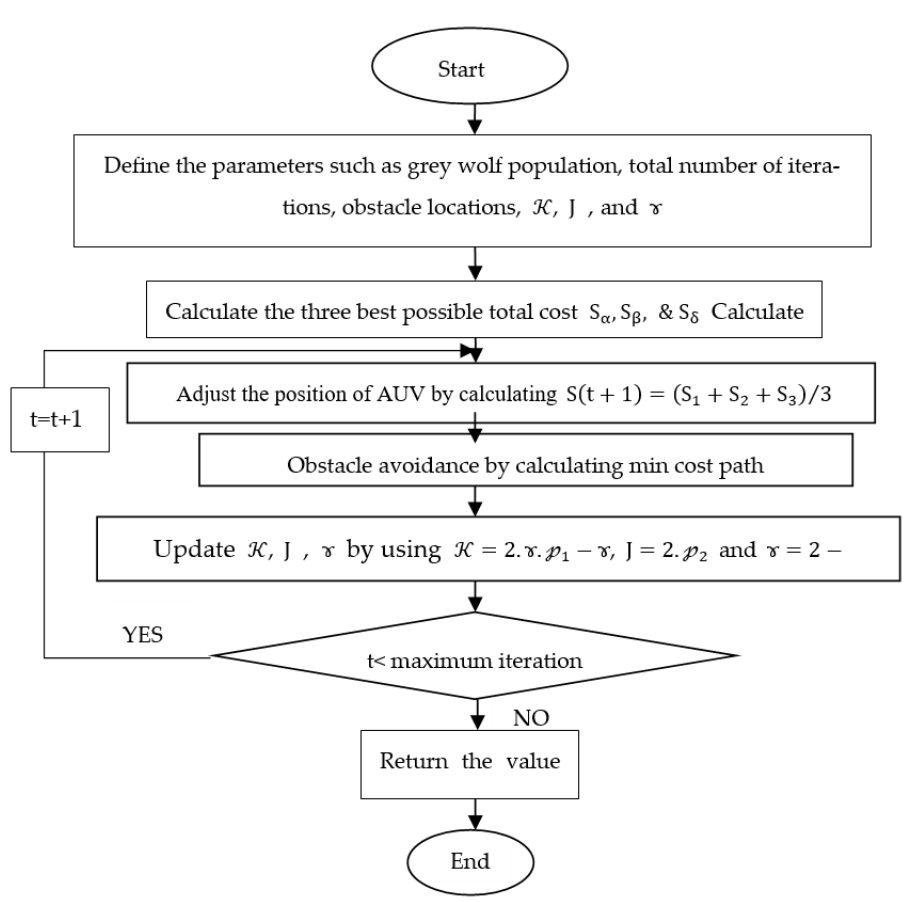
Figure 3. Path planning of an AUV using GWO.